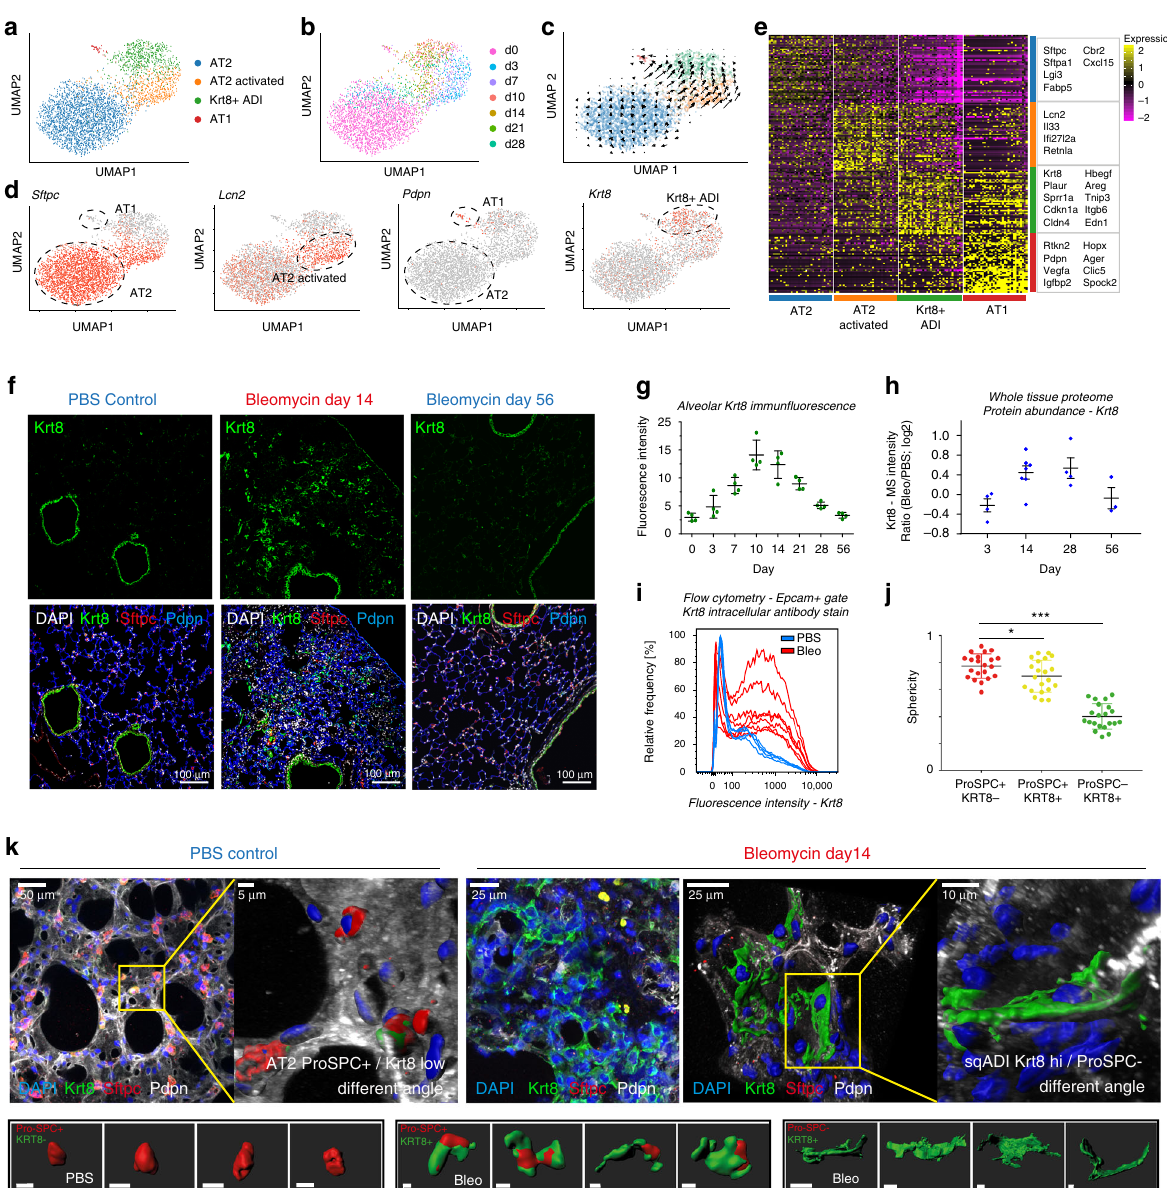
Fig. 3 Alveolar regeneration features a transient squamous cell state marked by Krt8 expression. a – d UMAP embedding of alveolar epithelial cells shows ( a ) four distinct cell states, and ( b ) the time points of sampling, and ( c ) the RNA velocity vectors, indicating AT2 cell differentiation towards the alveolar Krt8 + cell state after bleomycin-mediated injury, and ( d ) gene expression of the indicated marker genes. e Heatmap of top 50 differentially expressed genes across alveolar cell states, with selected marker genes in boxes. f Fluorescent immunostainings from the indicated conditions show nuclei (DAPI) in white, Krt8 in green, Sftpc (AT2 cells) in red, and Pdpn (AT1 cells) in blue (scale bar 100 microns). g Quanti fi cation of Krt8 mean fl uorescence intensity in alveolar space (excluding airways; n = 4 per time point, mean with SD). h Protein abundance of Krt8 in total lung homogenates was assessed by mass spectrometry 24 . Individual data points show log2 ratio of Krt8 MS-intensity after bleomycin injury [ n (d3) = 4, n (d14) = 7, n (d28) = 4, n (d56) = 3] versus PBS control mice ( n = 4). The mean and standard error of the mean is shown. i Krt8 fl uorescence intensity quanti fi ed by fl ow cytometry in epithelial cells. PBS control ( n = 5, blue color) and day 10 after bleomycin ( n = 7, red color) is shown. j Alveolar cell sphericity analysis of 21 cells per condition revealed elongated cell shapes for alveolar Krt8 + cells in IF-stained precision cut lung slices (in k ). Sphericity of 1 indicates round, cuboidal cells, 0 indicates fl at cells. PBS, n = 2; Bleo, n = 2. One-way ANOVA with Dunnett ’ s post testing: * p = 0.0376, *** p < 0.0001. k Maximum projections of confocal z-stacks taken from immunostained 300 micron-thick precision cut lung slices (PCLS) are shown for a representative PBS control mouse and a mouse at day 14 after bleomycin injury. Nuclei (DAPI) are colored blue, Krt8 appears in green, Sftpc (AT2 cells) in red, and Pdpn (AT1 cells) in white. Image data representation stems from n = 5 samples. Small images below show examples taken for cell morphometric analysis (in j ). All scale bars in small single-cell images represent 15 µ